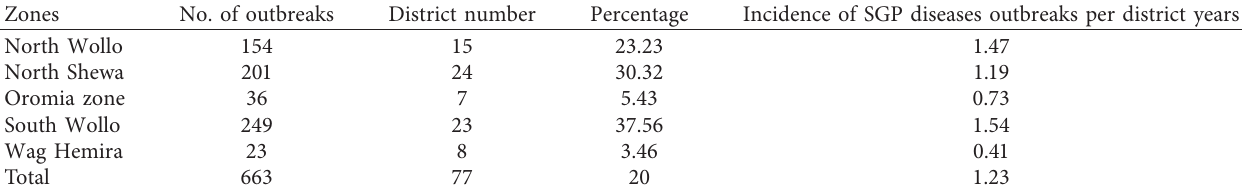
Table 5: Incidence and spatial distribution of SGP disease outbreaks in Eastern Amhara zones from September 2013 to December 2019. Zones